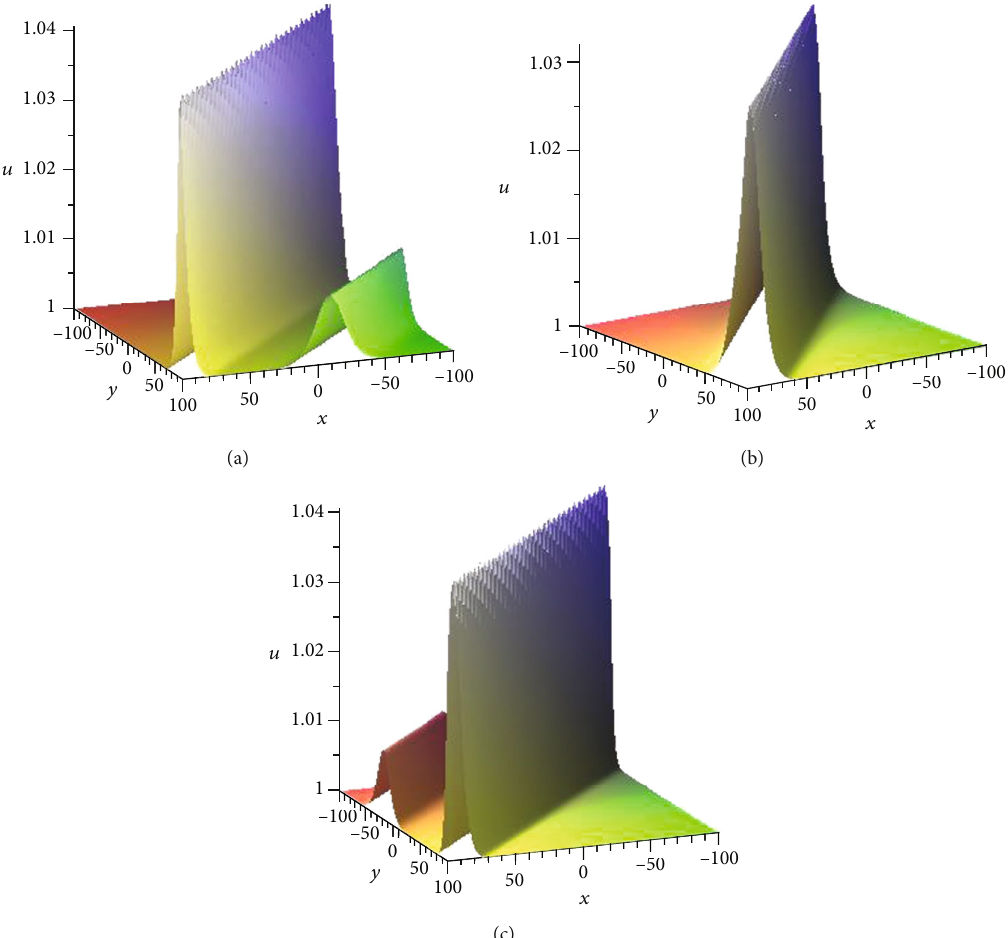
= 15 and β 0 = 0 . (b) Asymmetric soliton in β 0 1 2